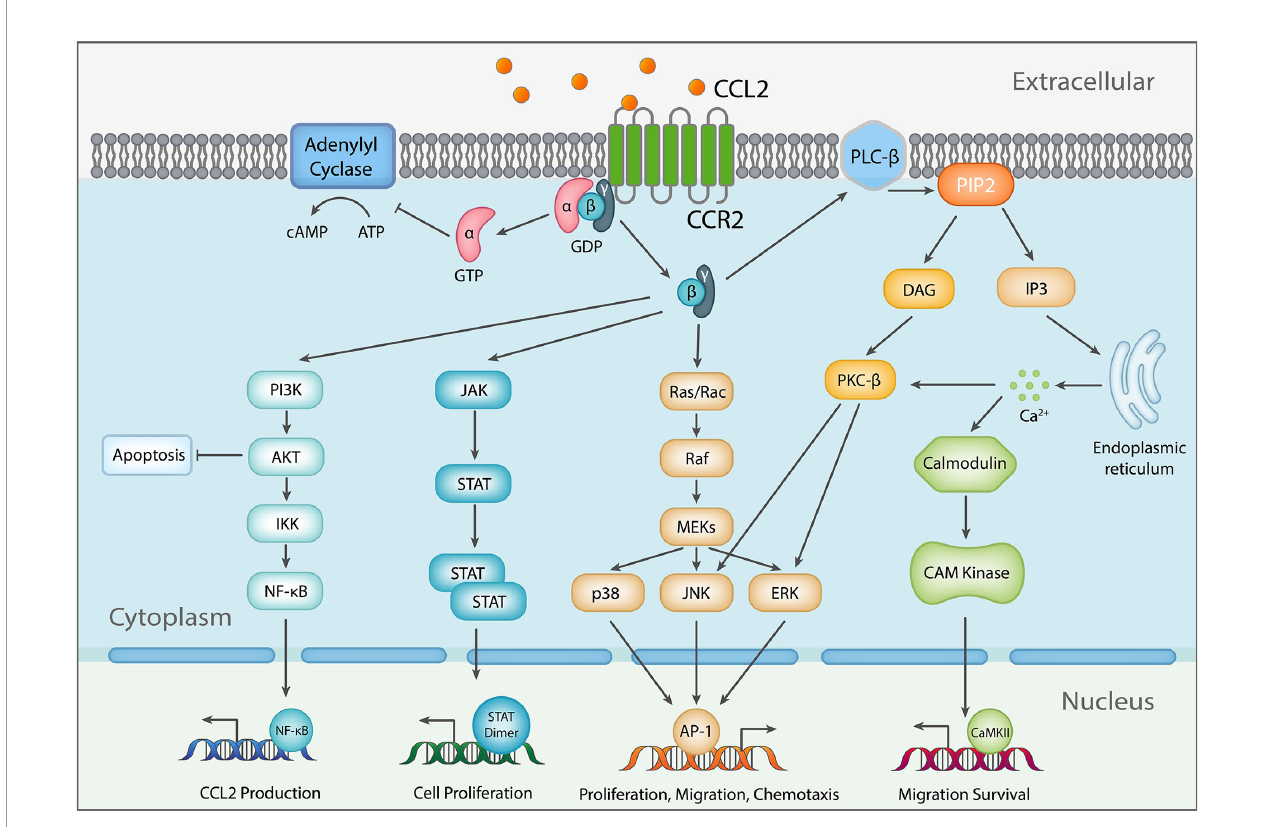
FIGURE 1 | Schematic diagram of CCL2 signaling. As a response to CCL2 binding at the N-terminus, extracellular loops and transmembrane bundle of CCR2, the intracellular G-protein a i subunit dissociates from the CCR2 and the bg subunit. The a subunit then inhibits adenylyl cyclase (AC) function resulting in decreased cyclic adenosine monophosphate levels. In contrast, the bg subunit signaling induces gene expression via several pathways, further inducing changes to cellular function [Adapted from